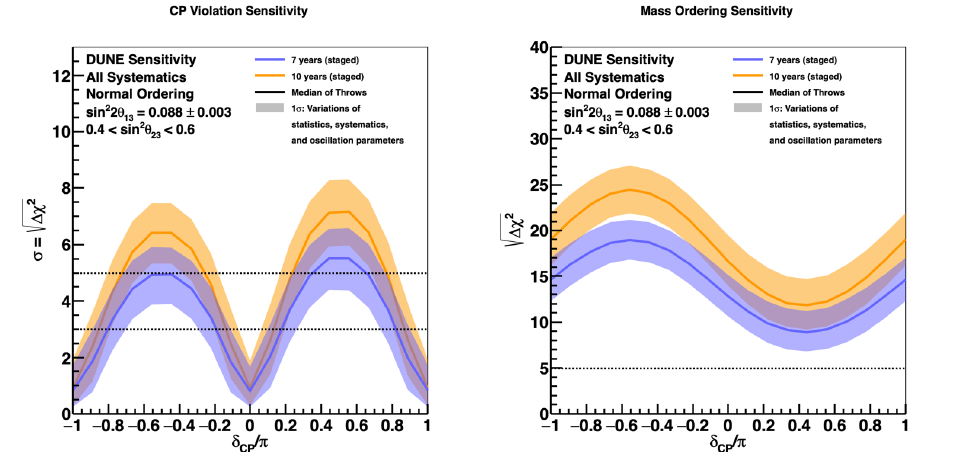
Figure 10. ( Left ): Significance of the DUNE determination of CPV ( δ CP (cid:54) = [ 0, ± π ] ) as a function of the true value of δ CP , for seven (blue) and ten (orange) years of exposure, in normal ordering. ( Right ): Significance of the DUNE determination of the neutrino mass ordering, as a function of the true value of δ CP , for seven (blue) and ten (orange) years of exposure, in normal ordering. The width of the transparent bands cover 68% of fits in which random throws are used to simulate systematic, oscillation parameter and statistical variations, with independent fits performed for each throw constrained by prior uncertainties. The solid lines show the median significance [39].